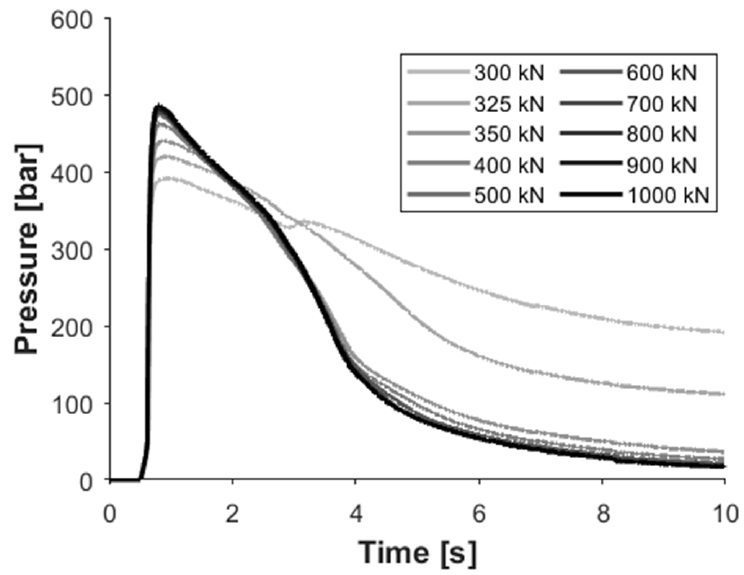
Figure 2. In-mold pressure change as a function of time at different clamping forces (cavity 04, post-gate sensor).